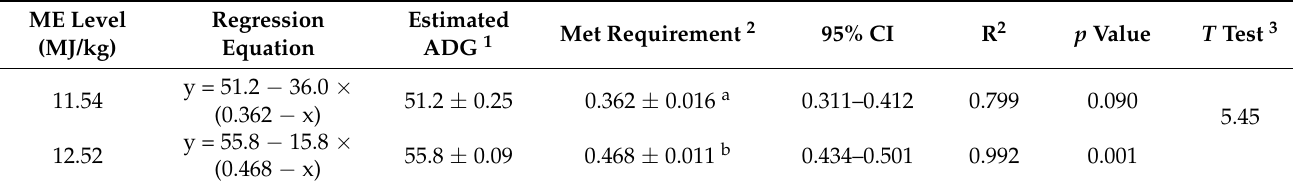
Table 7. Methionine requirements of starter Pekin ducks from 1 to 21 days of age fed two different ME levels using the linear broken-line